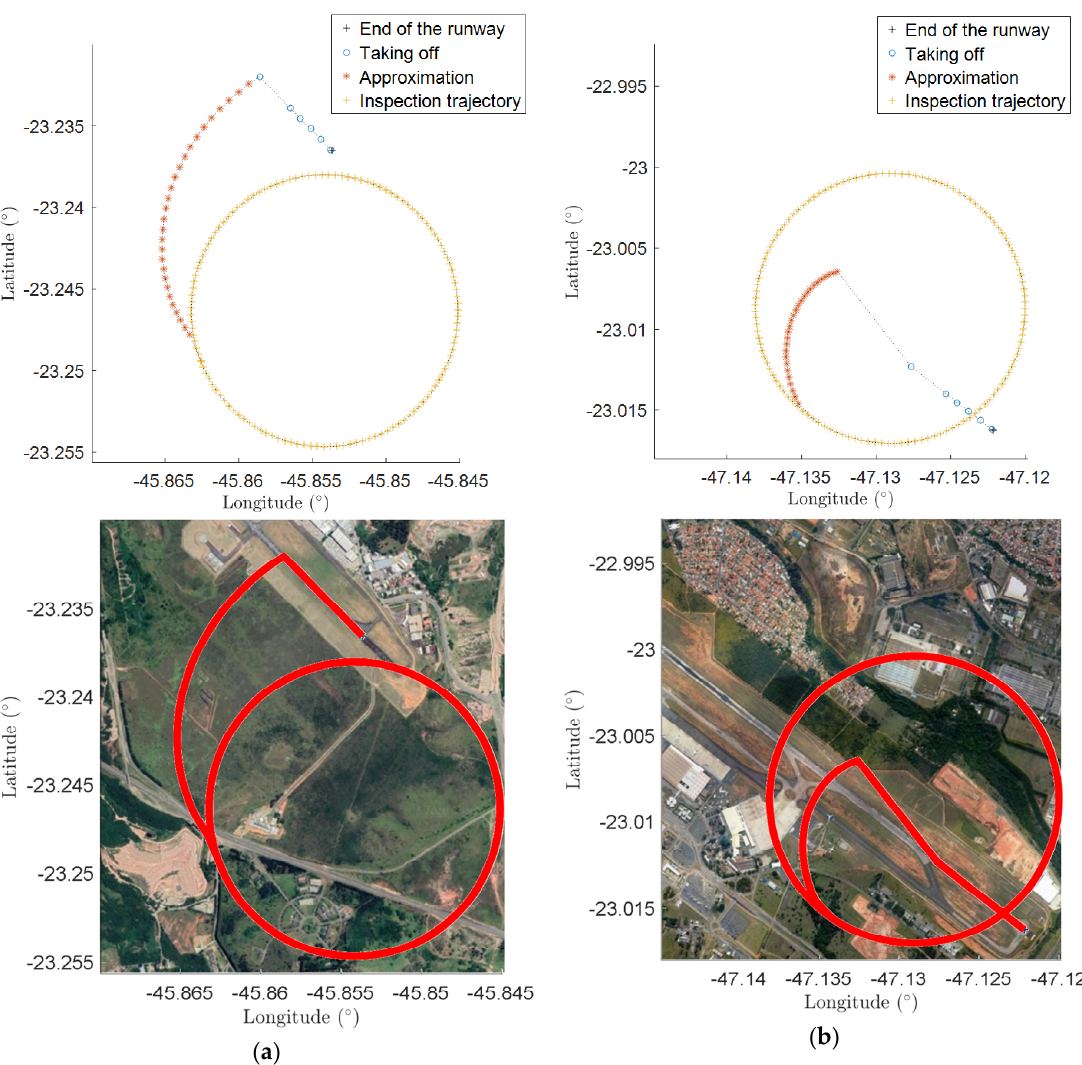
Figure 7. Automatically generated trajectories. Longitude and latitude and its drawing using Google Maps: ( a ) SJK (São José dos Campos—Brazil) airport; ( b ) VCP (Campinas—Brazil) airport.